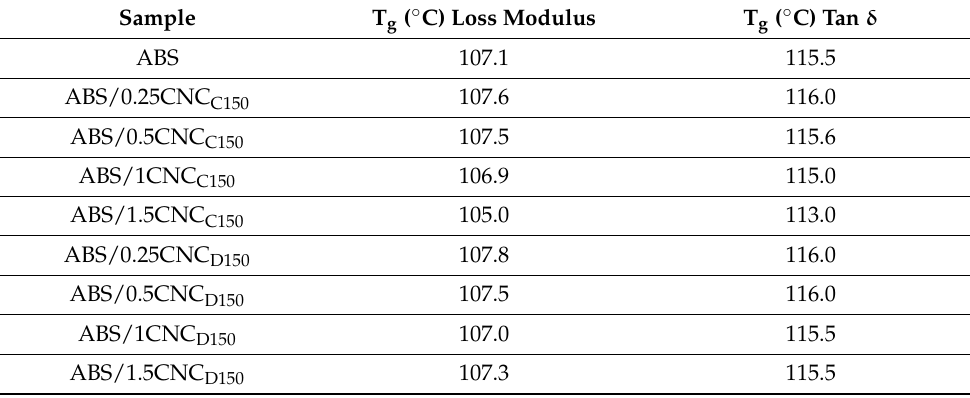
Figure 10. Tan δ ( a ), loss modulus ( b ), and storage modulus ( c ) of the ABS/modified CNC nanocomposites studied. Table 5. Glass transition temperatures (T g ) of the ABS/modified CNC nanocomposites obtained by DMA. Sample